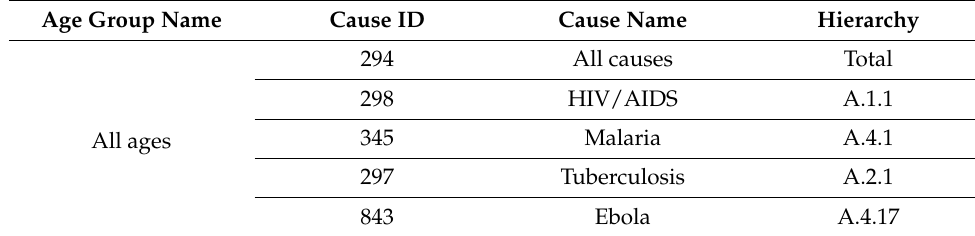
Table 2. DALYs data (except VPDs).